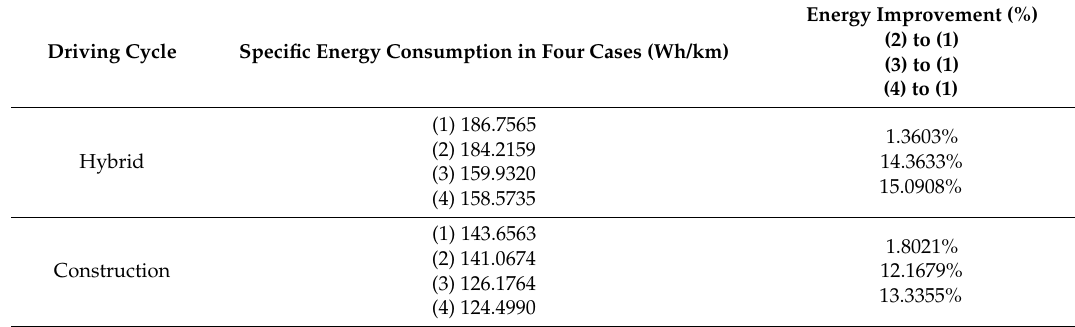
Table 4. Energy consumption in four cases.